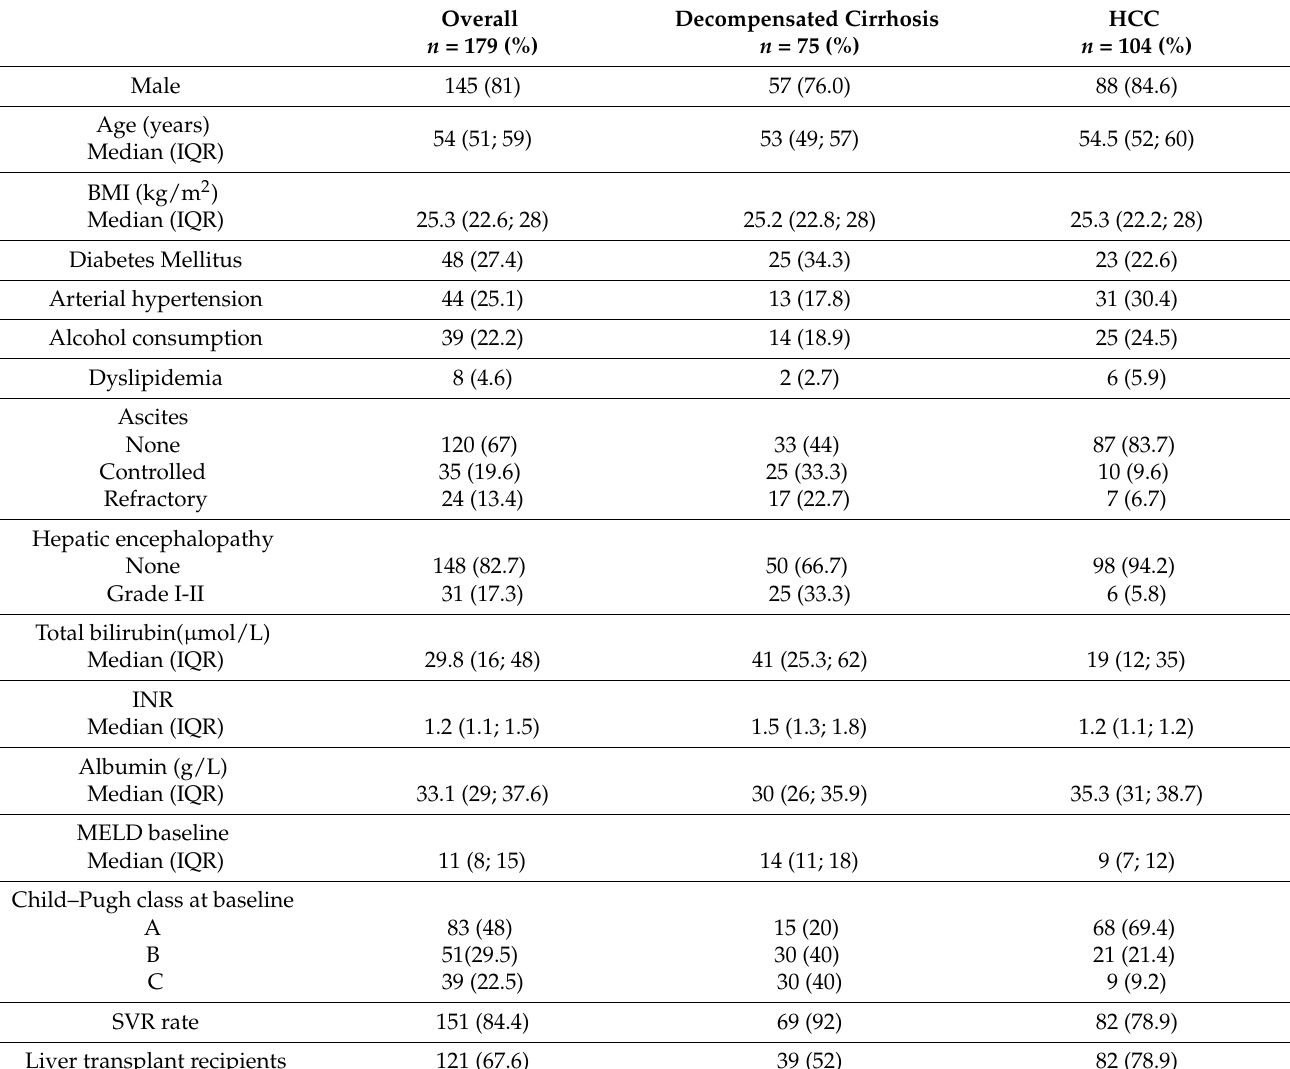
Table 1. Baseline characteristics of the 179 patients awaiting LT and treated for